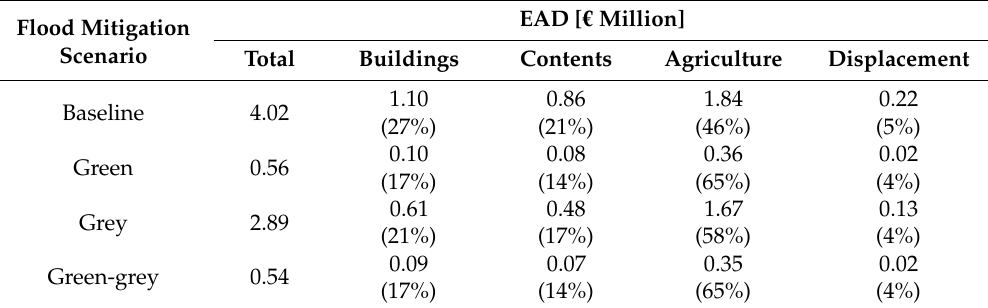
Table 6. Expected annual damages (EADs) and their breakdown per loss category under different flood mitigation scenarios.